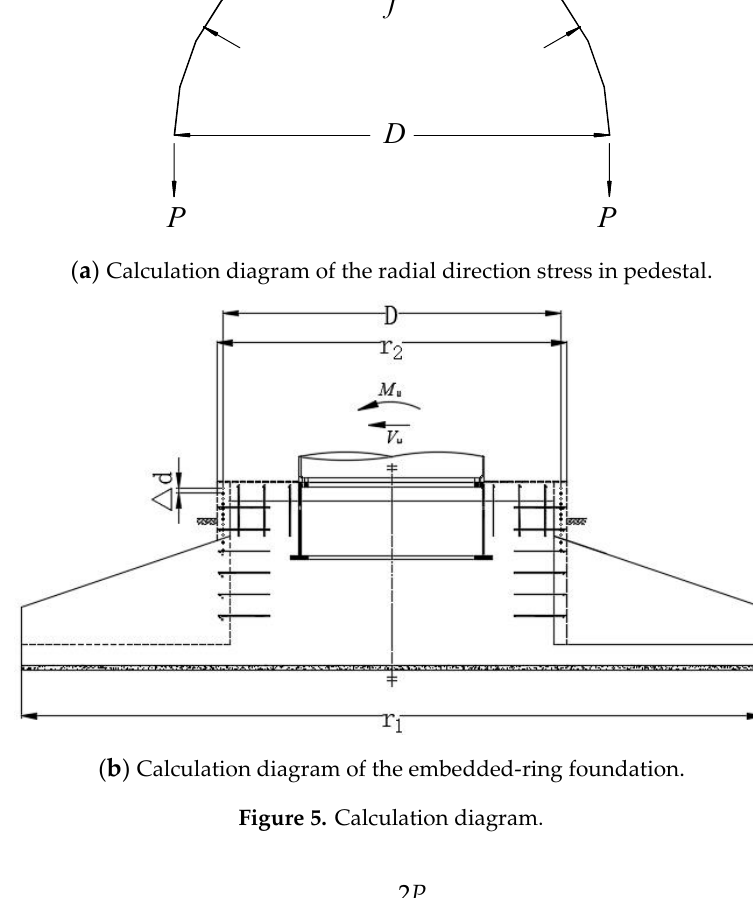
( b ) Calculation diagram of the embedded-ring foundation. Figure 5. Calculation diagram.